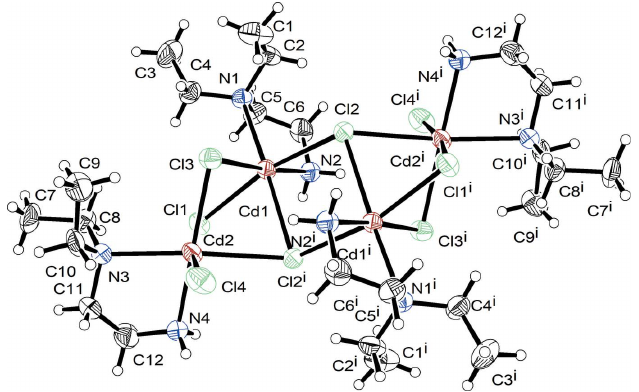
Figure 1 An ORTEP representation of the complex showing 50% probability ellipsoids (only the major component of the disordered ligand is shown). Symmetry code: (i) 1 (cid:2) x , 1 (cid:2) y , (cid:2) z .